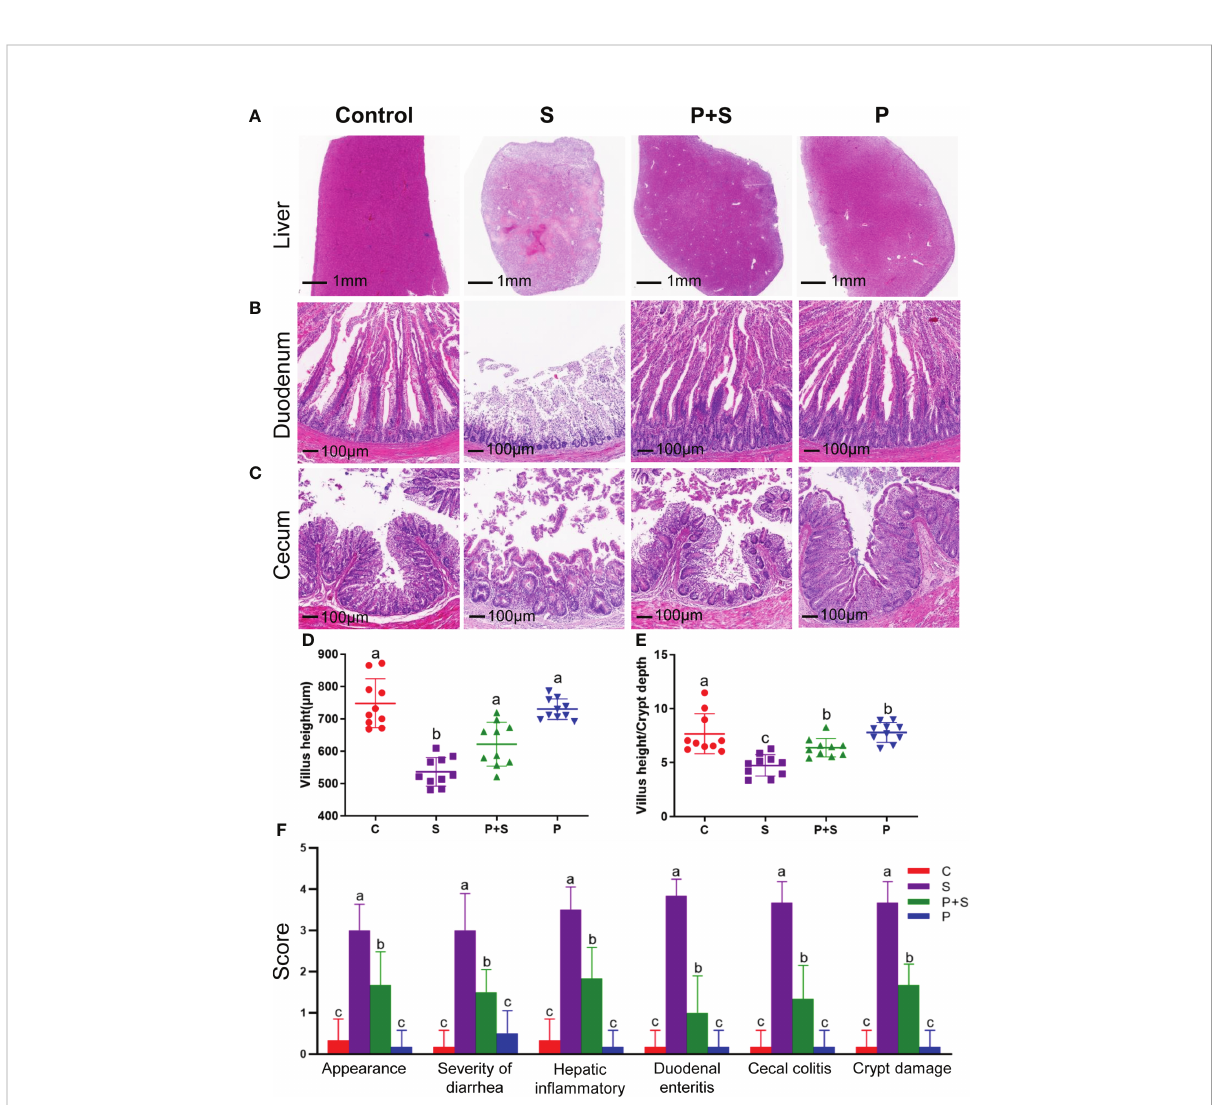
FIGURE 2 Pathological, changes of intestinal villus, clinical score and intestinal in fl ammation score in different groups. (A – C) Effects of different treatments on histopathology and (D) changes of villi height and (E) ratios of villi height to crypt depth in the duodenum, and (F) histological in fl ammation scores of each organization in newly hatched chicks. a, b, c: indicated the same item with different letters differ signi fi cantly ( P <